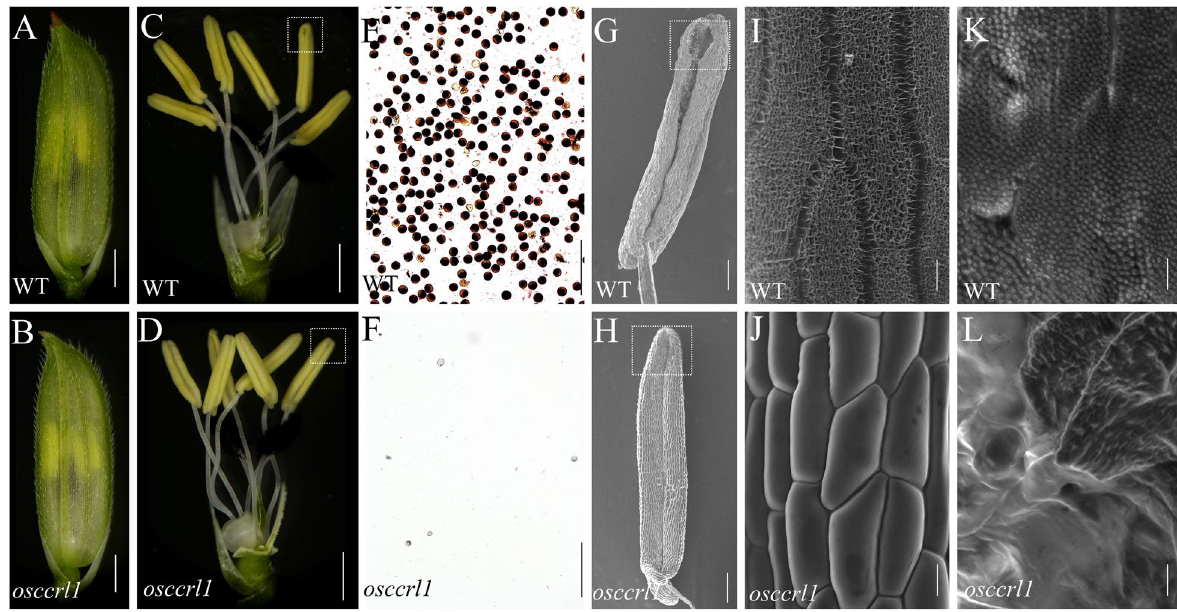
Fig. 1 Phenotypic comparison between the WT and the osccrl1 mutant. A , B Spikelet of the wild type and osccrl1 mutant. Scale bars, 5 mm. C , D Spikelet of the wild type and osccrl1 mutant after removal of the palea and lemma. Scale bars, 5 mm. E , F Pollen grains of the wild type and osccrl1 mutant stained by I 2 /KI solution. Scale bars, 200 μm. G , H The scanning electron microscopy of anther in wild type and osccrl1 mutant. Scale bars, 200 μm. I , J The scanning electron microscopy of anther epidermis surface in wild type and osccrl1 mutant. Scale bars, 50 μm. K , L The scanning electron microscopy of anther inner surface in wild type and osccrl1 mutant. Scale bars, 50